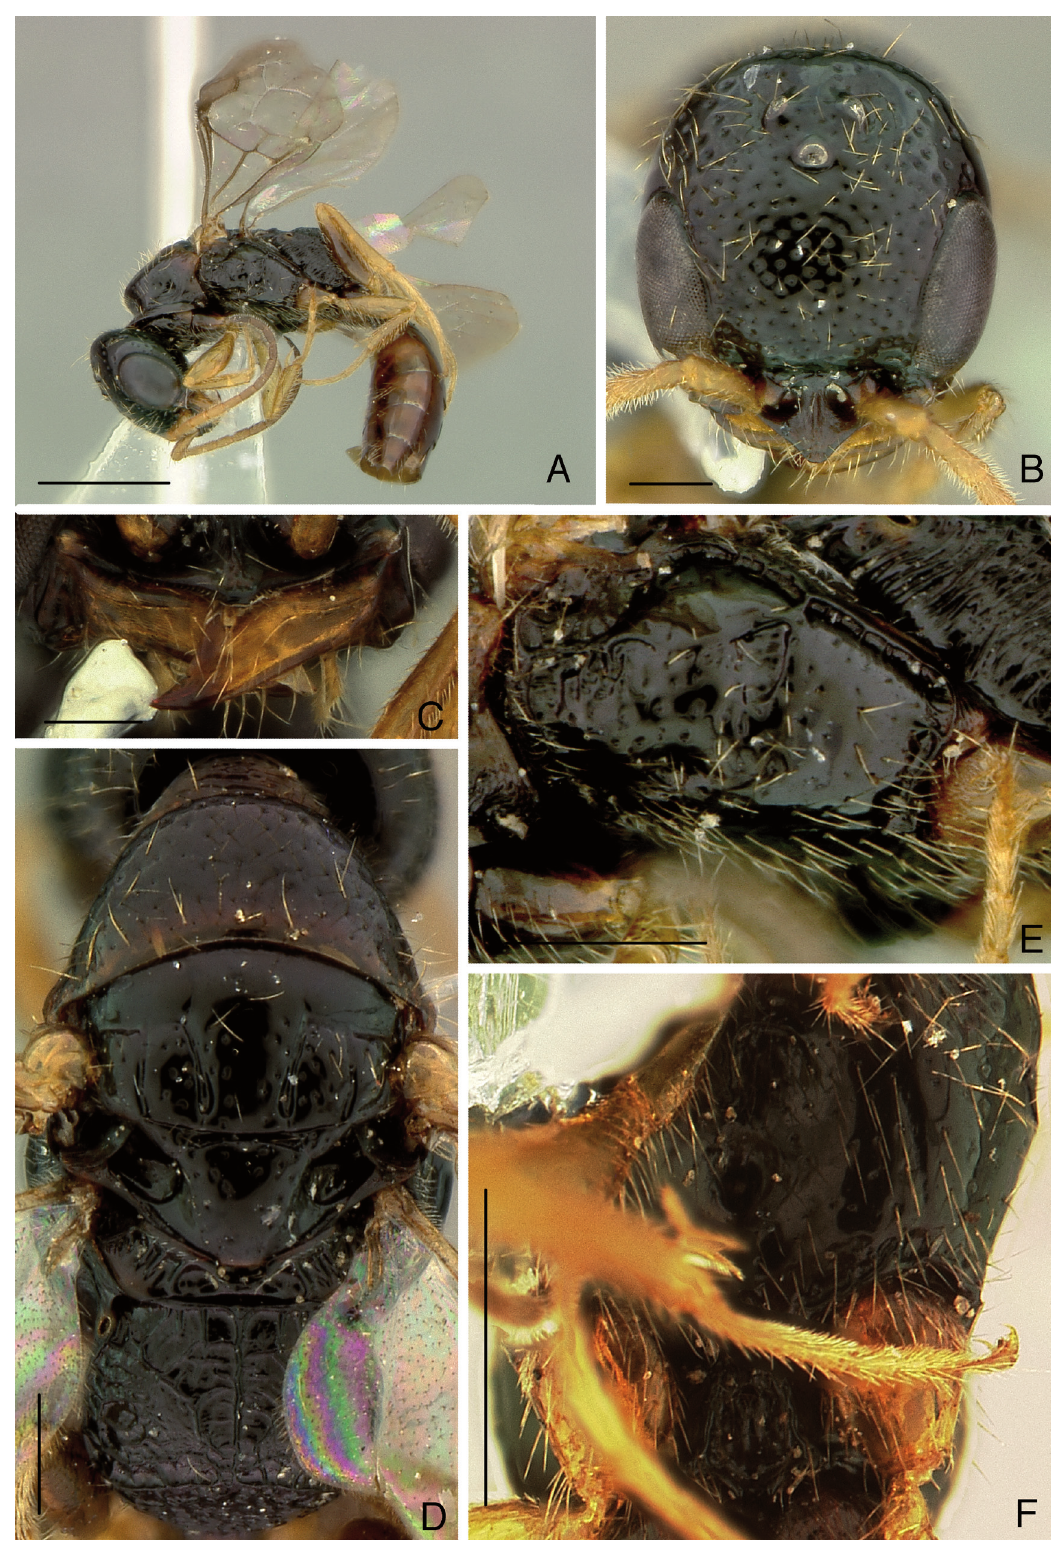
Fig. 4. Apenesia tagala comb. nov., holotype, ♂. A . Habitus. B . Head, dorsal view. C . Mandible, frontal view. D . Mesosoma, dorsal view. E . Mesopleuron, lateral view. F . Mesosoma, ventral view (bars 0.25